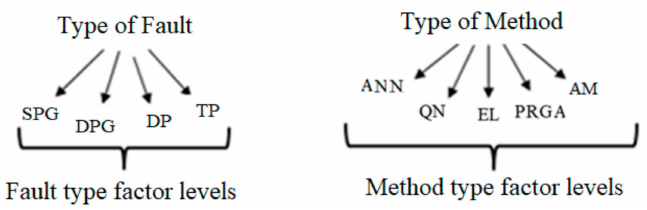
Figure 14. Factors and levels of the location